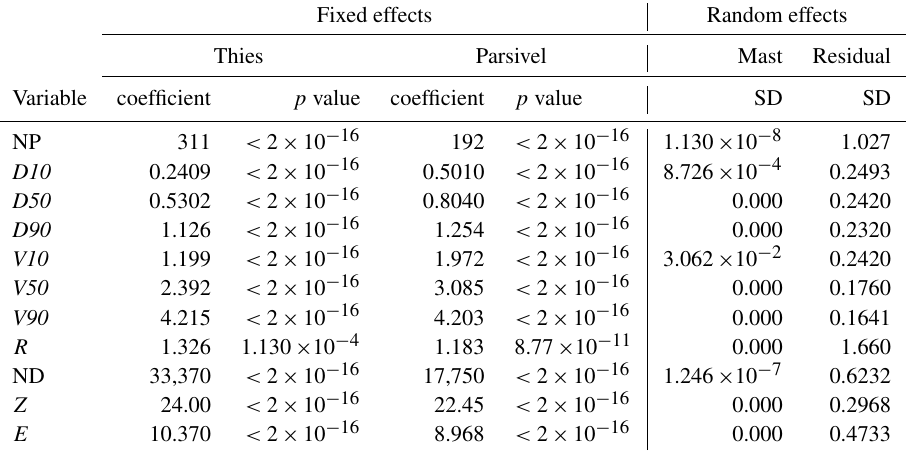
Table A1. Gamma generalized linear mixed-effects model coef- ficients for 1min records, with no corrections of the PSVD data ( N =